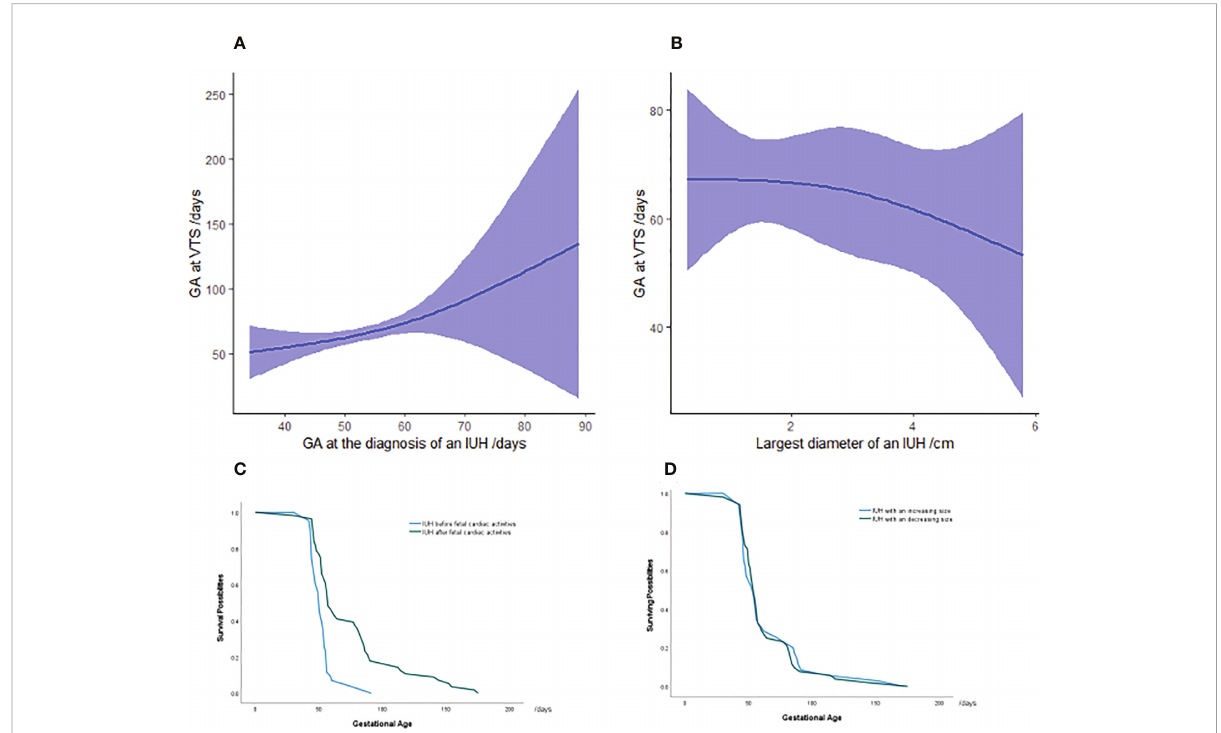
FIGURE 2 Association between gestational age at miscarriage and IUH characteristics in vanishing twin syndrome patients (A, B) Survival analysis in pregnancies with an IUH diagnosis at the presence or absence of fetal cardiac activities (C) and an increasing or decreasing volume of hematoma (D) in VTS patients. The green and blue lines represent the surviving possibilities of fetuses in vanishing twin syndrome as gestational age progressed. The majority of VTS occurred between 50 and 100 days of gestation, and the y-value represents the percentage of remaining vanishing twins who will be miscarried later. Each color symbolizes IUH patients with the hematoma diagnosed before or after fetal cardiac activity and the either increasing or decreasing volume of an IUH. GA, gestational age; IUH, intrauterine